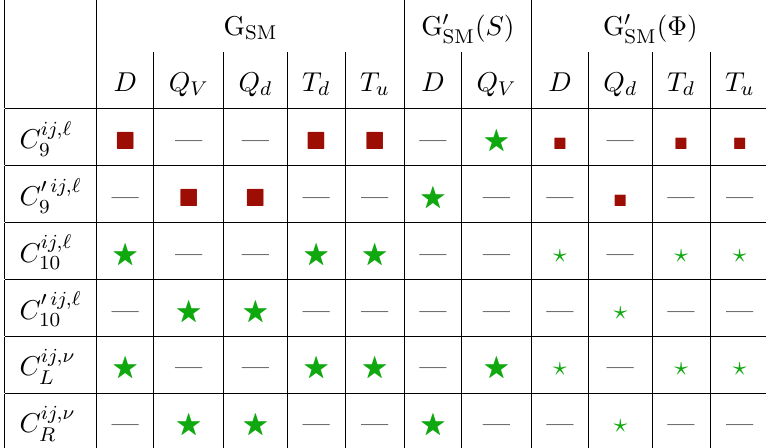
s(cid:22) + (cid:22) (cid:0) Wilson coe(cid:14)cients C ( 0 ) and to 9 ; 10 ! ((cid:8)) models indicate the SM